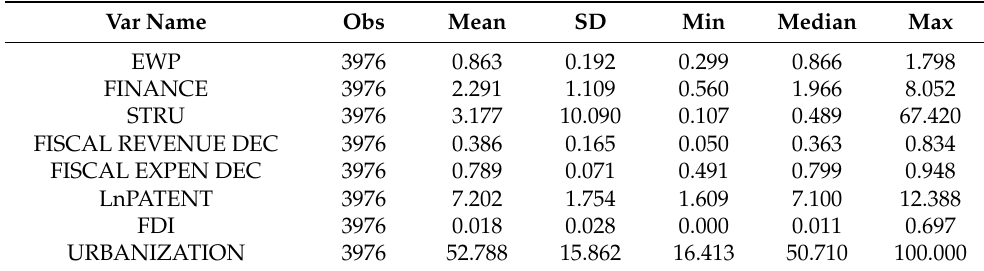
Table 5. Descriptive statistical